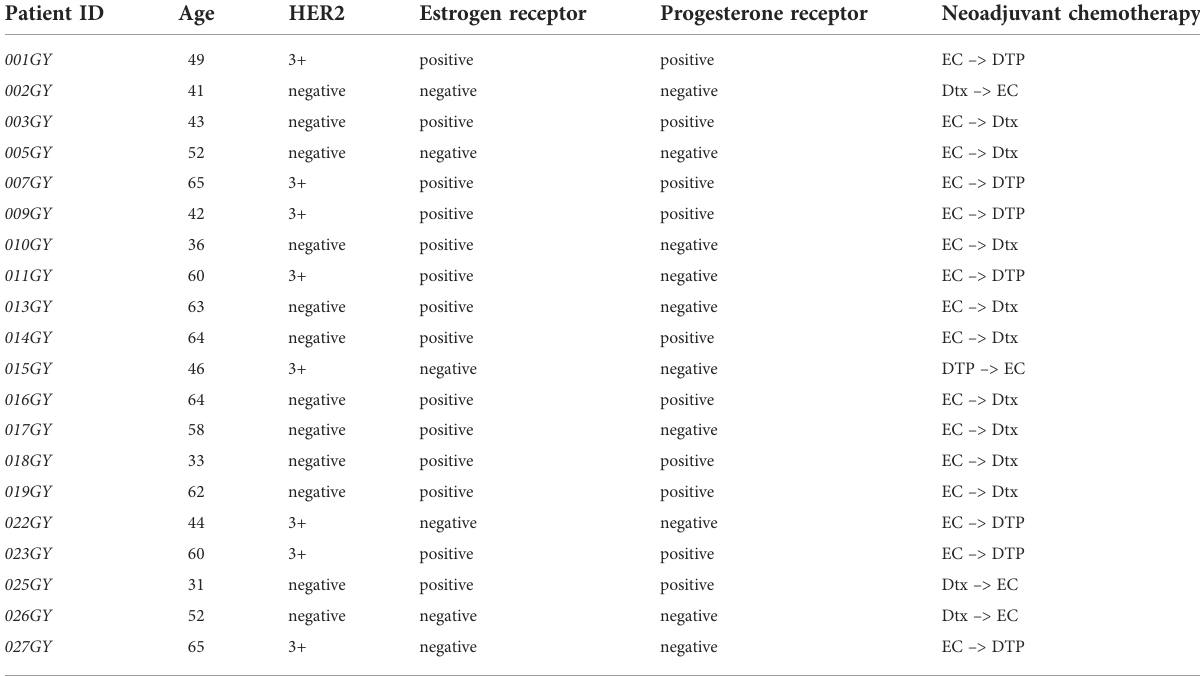
TABLE 1 Detailed clinical information and patient annotations on the 20 breast cancer patients included in the study. Patient